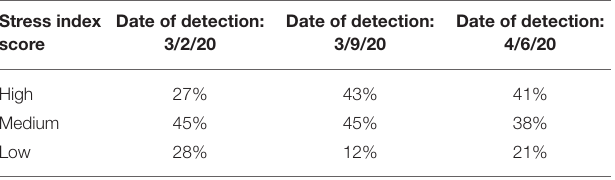
TABLE 1 | Stress index score variation among adult population before and after the announcement of the nationwide lockdown in Italy.